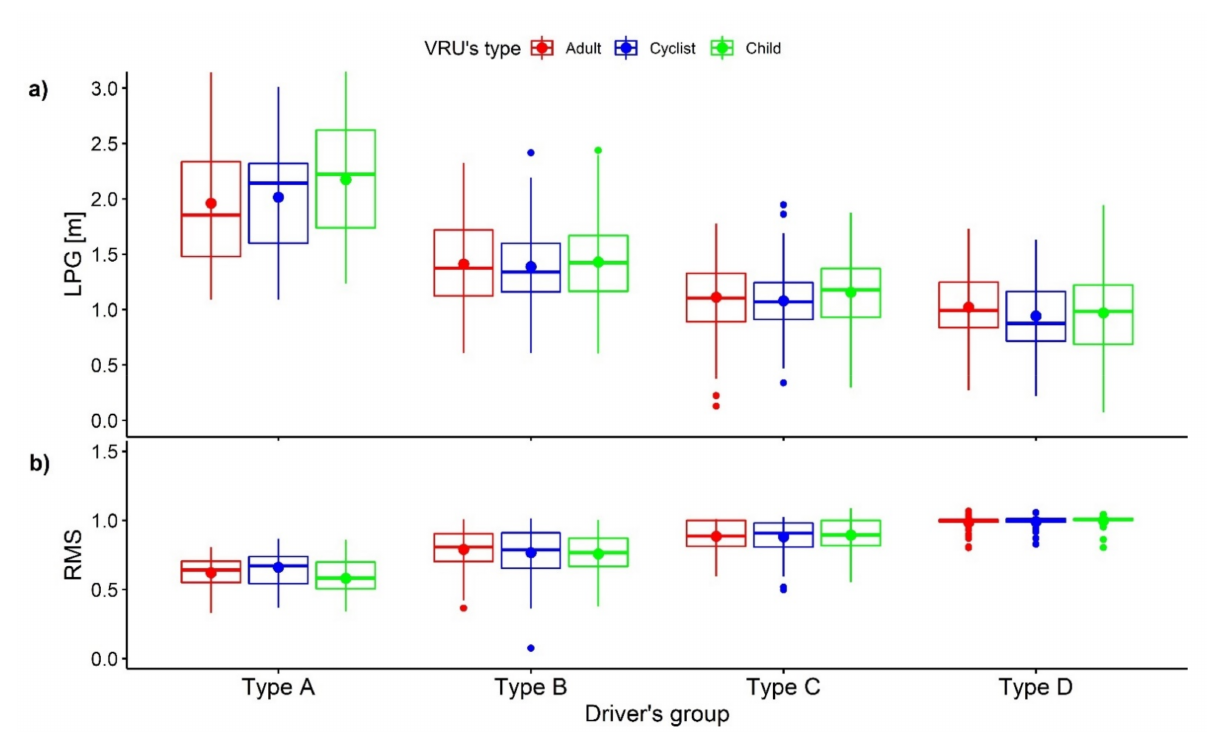
Figure 7. Box plot of the minimum lateral gap while passing VRU ( a ) and the ratio of SV’s minimum velocity to initial speed while approaching VRU ( b ), grouped by VRU’s type between driver’s groups.